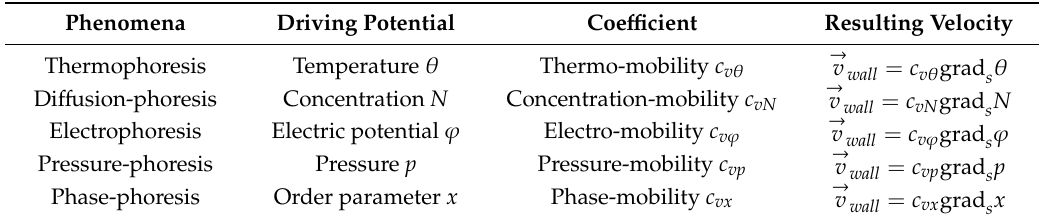
Table 2. Five kinds of motions connected with a surface mobility of a particle immersed in a rest fluid. Here: c v θ —the thermo-mobility coe ffi cient, c vN —the concentration-mobility coe ffi